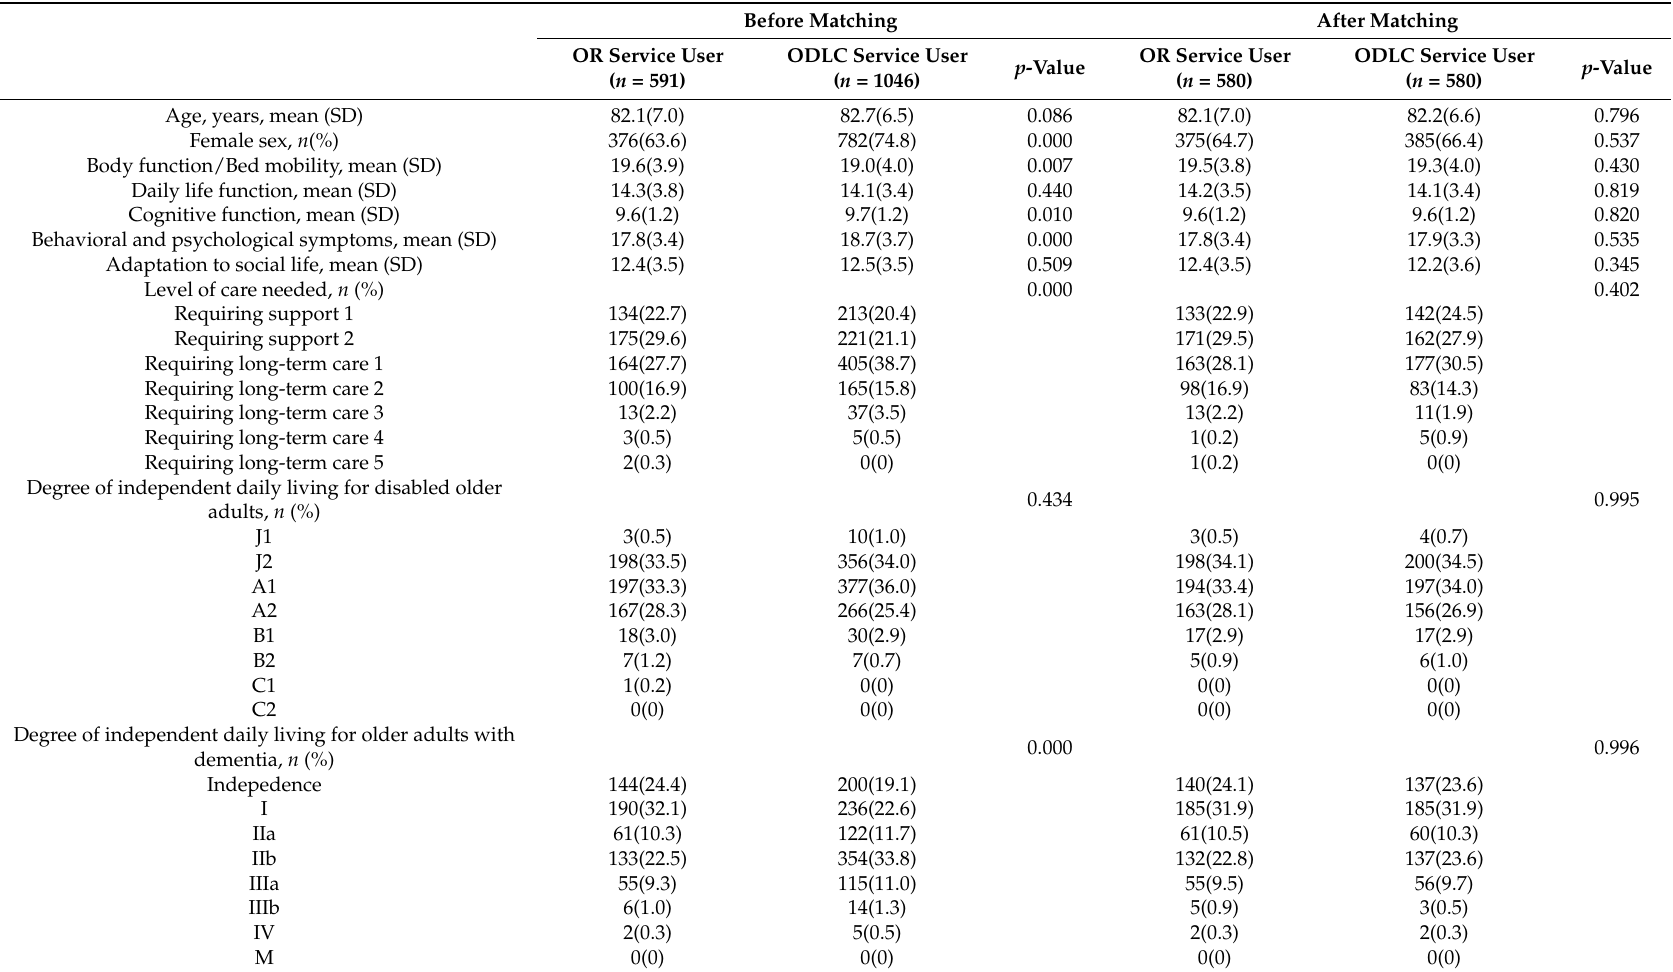
Table 1. Sample characteristics before and after propensity score